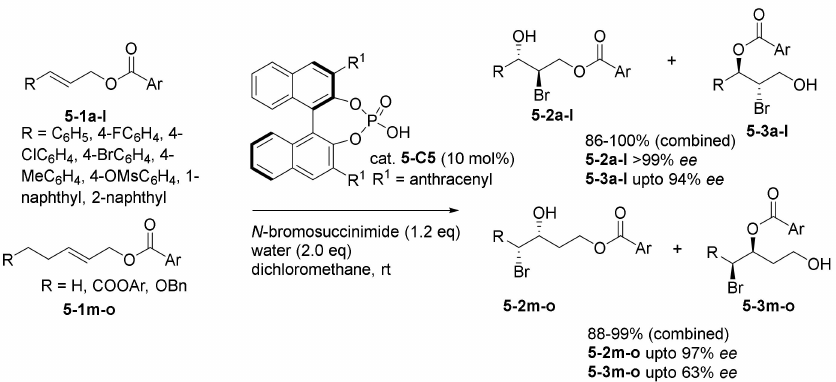
Scheme 10. Enantioenriched bromohydrin synthesis by anchimeric oxygen